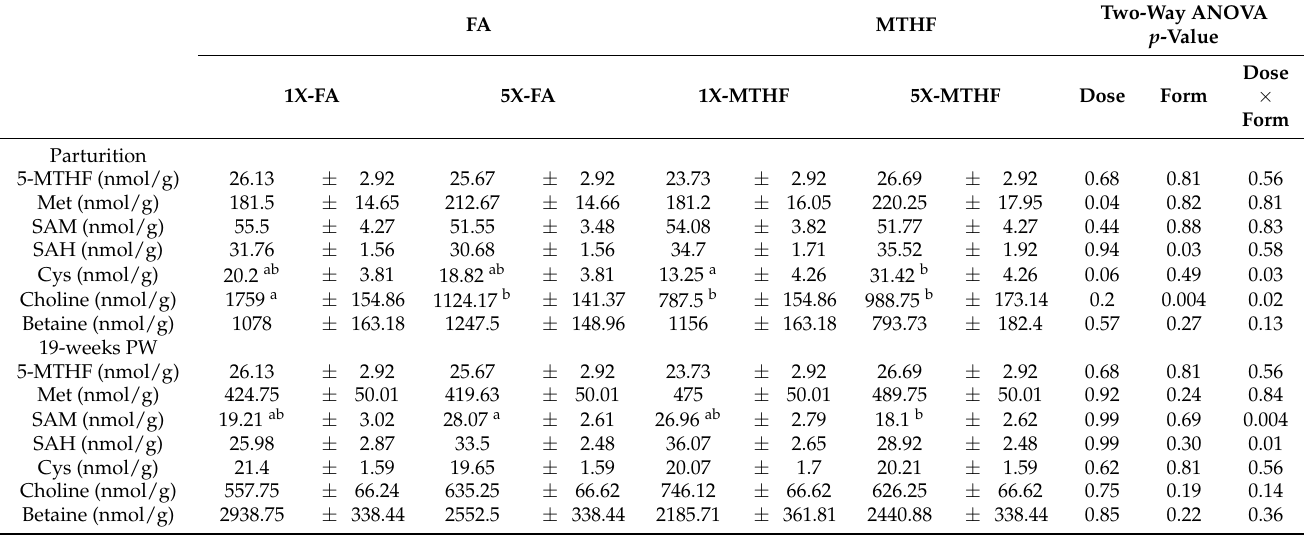
Table 2. Hepatic 5-MTHF and 1-carbon metabolites upon parturition and at 19-weeks post-weaning (PW) of dams fed FA or MTHF pregnancy